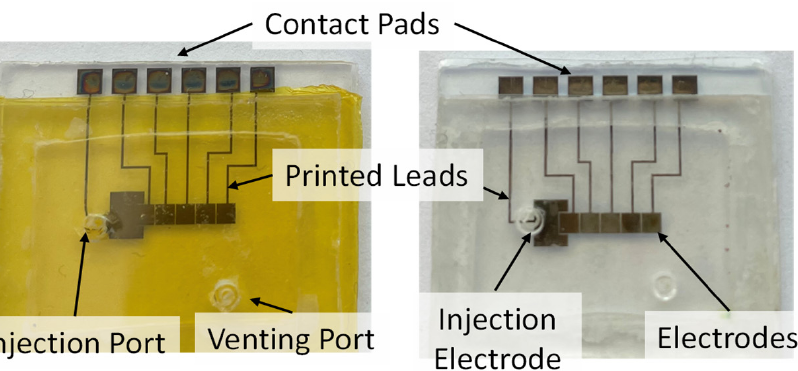
Figure 3. Left—assembled two-plate DMF cartridge with Kapton tape dielectric layer. Right— assembled two-plate DMF cartridge with PMMA dielectric layer.